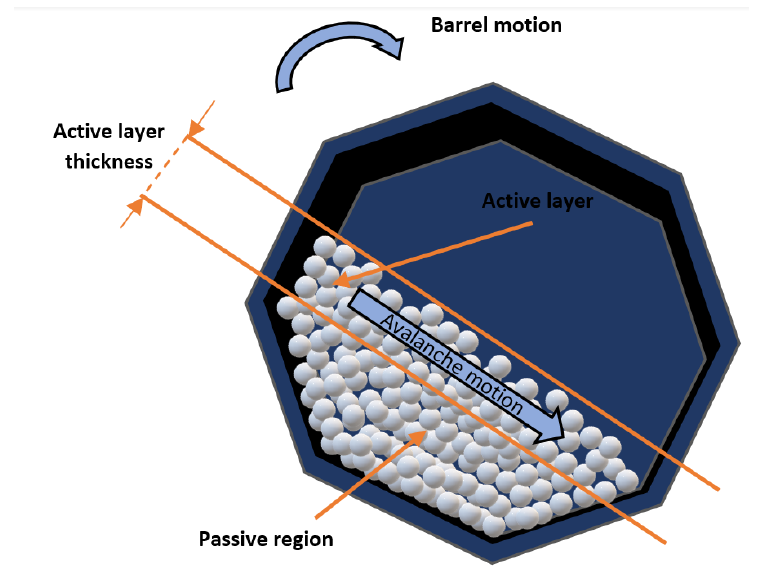
Figure 3. Barrel finishing operation.